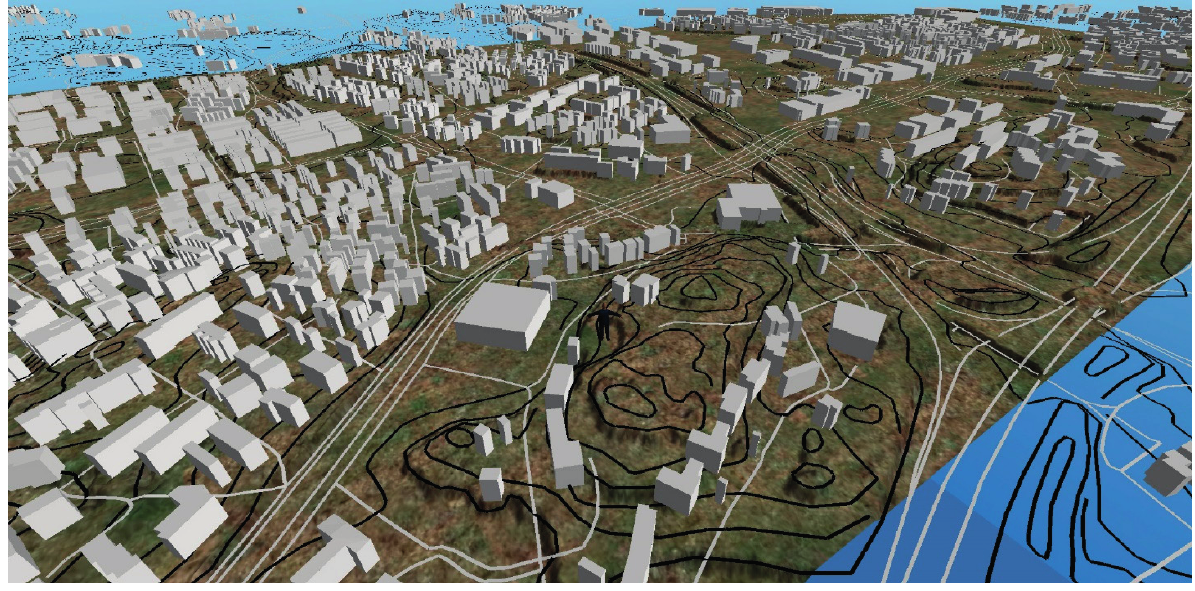
Figure 5. Buildings, roads, terrain, and contours in Meshmoon in an early, manually created